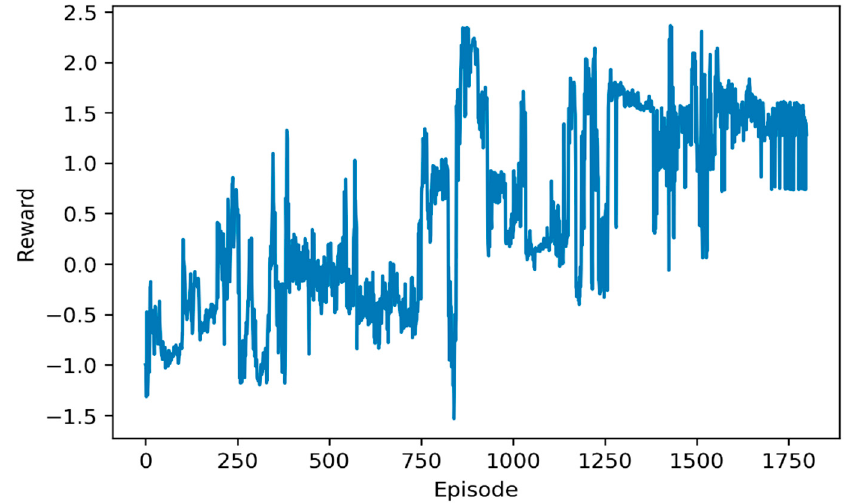
Figure 14. Rewards during the training process under continuously sampling random disturbances in